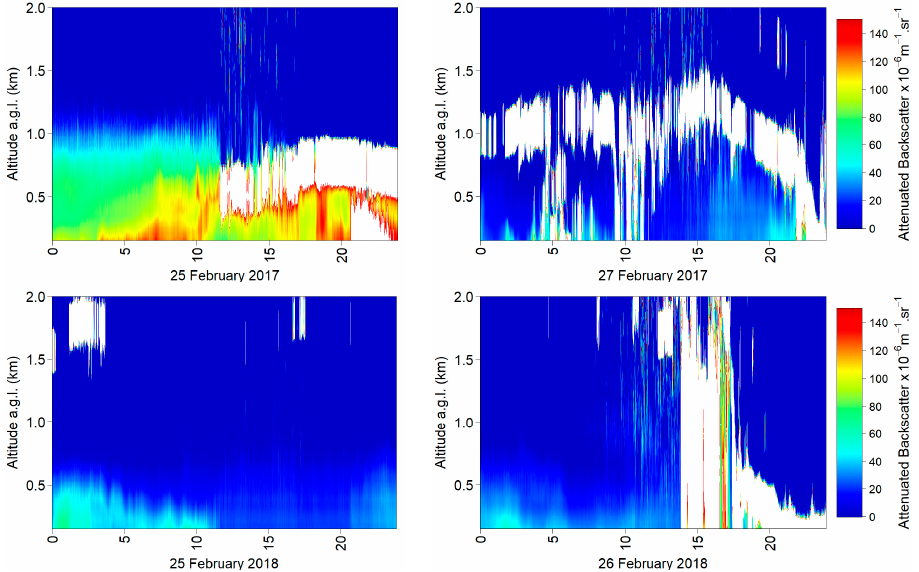
Figure 8. Ceilometer attenuated backscatter on 25 and 27 February 2017 and 25 and 26 February 2018. Clouds are represented in white and are observed over the observatory in the four days.